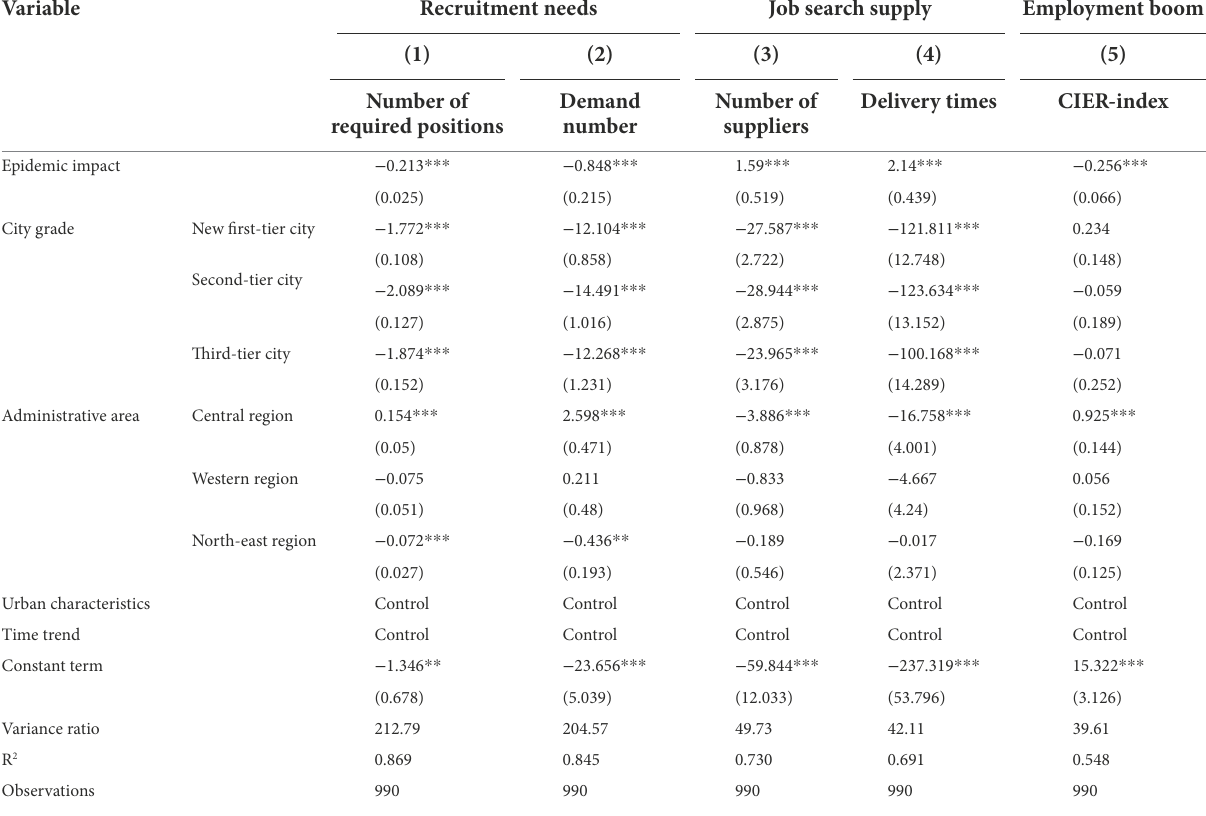
TABLE 2 Impact of epidemic on employment of college graduates.